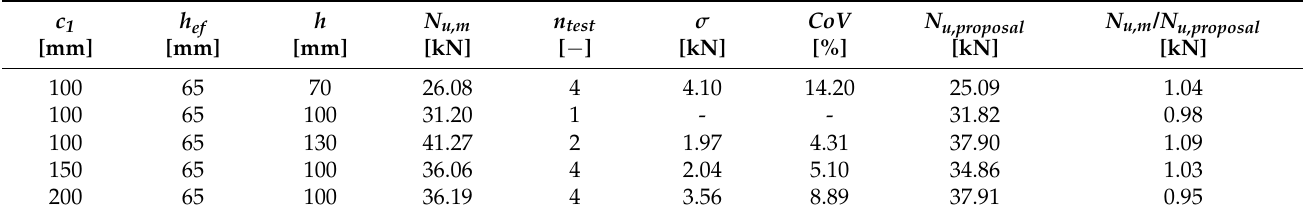
Table 9. Experimental results—installation near the